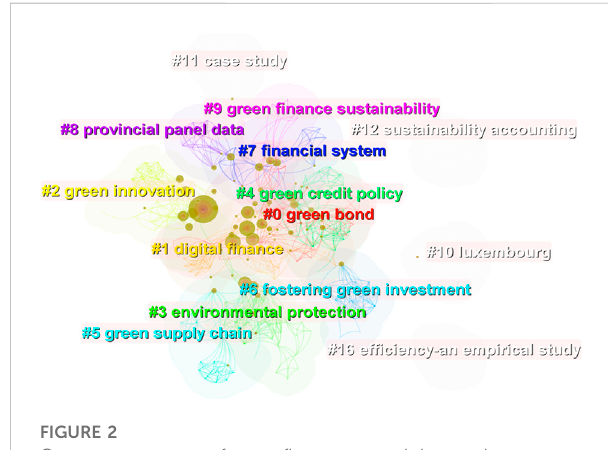
FIGURE 2 Co-occurrence map of green fi nance research